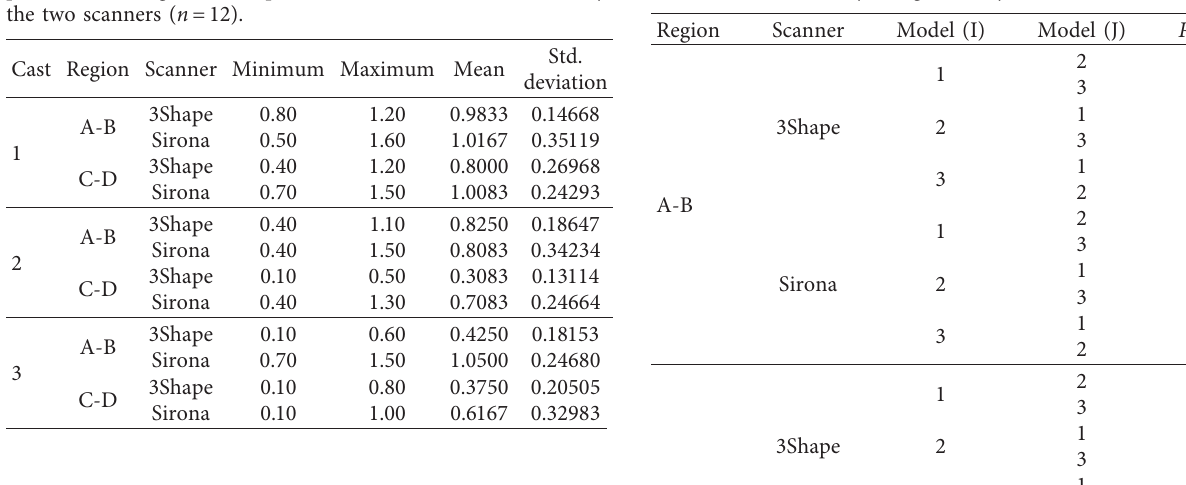
Table 2: Comparison of the two scanners separately in each model and in the right and left quadrants using the paired sample t -test.